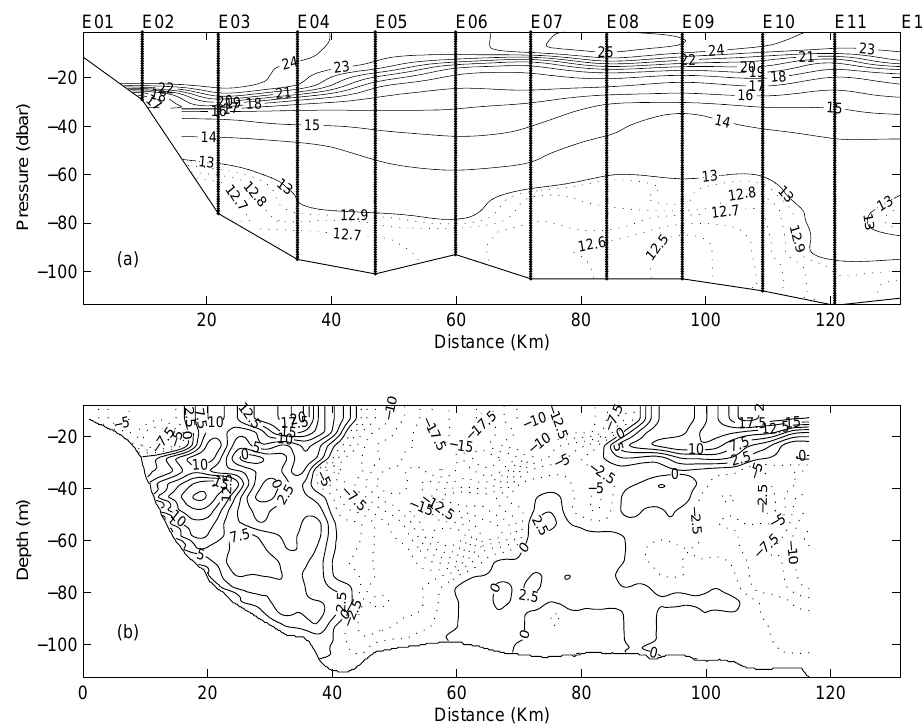
Fig. 15. Temperature field (a) and residual currents (b) at transect E on 26 August 1995. The component of the current perpendicular to the section is depicted. Positive values mean southward flow. No data are available in the layer from the surface to the 9m